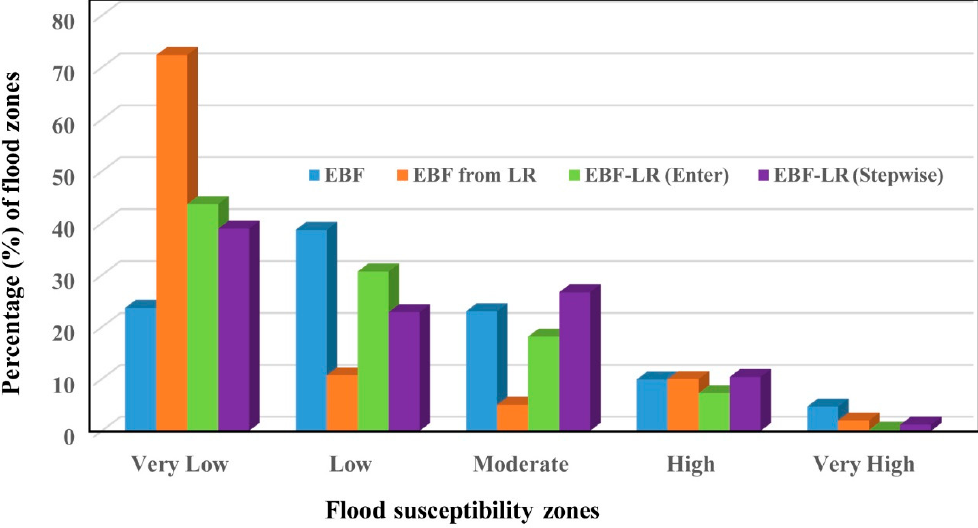
Figure 7. The success and prediction-rate curves for flooding map; ( a ) success rate and ( b ) prediction rate.